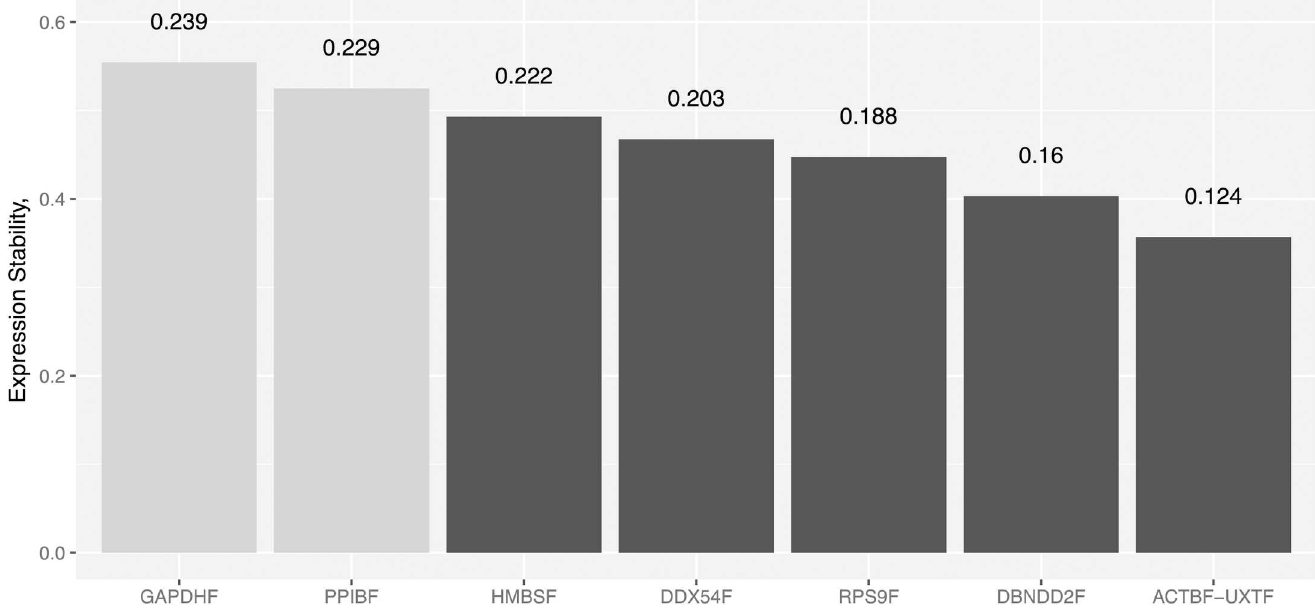
Fig 2. geNorm ranking of 8 referencegenes from bovine rumen samples. Vertical numbers at the top indicate the CV values of the reference genes involvedin the normalization. References showinghighly stable expression( M values < 0.5) are represented as black bars.